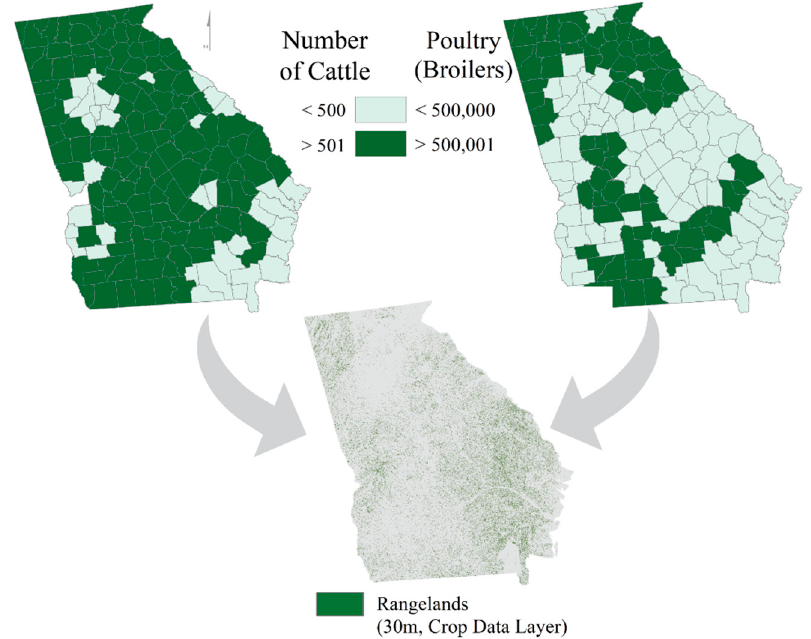
Figure 9. Maps of Georgia showing the number of cattle and poultry by county along with locations of 30 m rangelands (Crop Data Layer; USDA NASS 2020) that have potential to be grazed by cattle and fertilized by broiler litter. Rangelands here are categorized based on the Crop Data Layers corresponding to Grass/Pasture, Shrubland, and Other Hay/Non-Alfalfa.